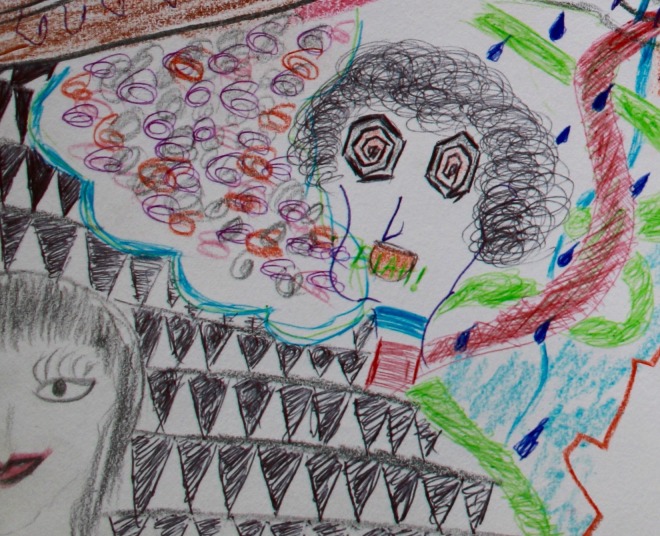
Representation of researcher engagement styles (Aggett, 2015b).